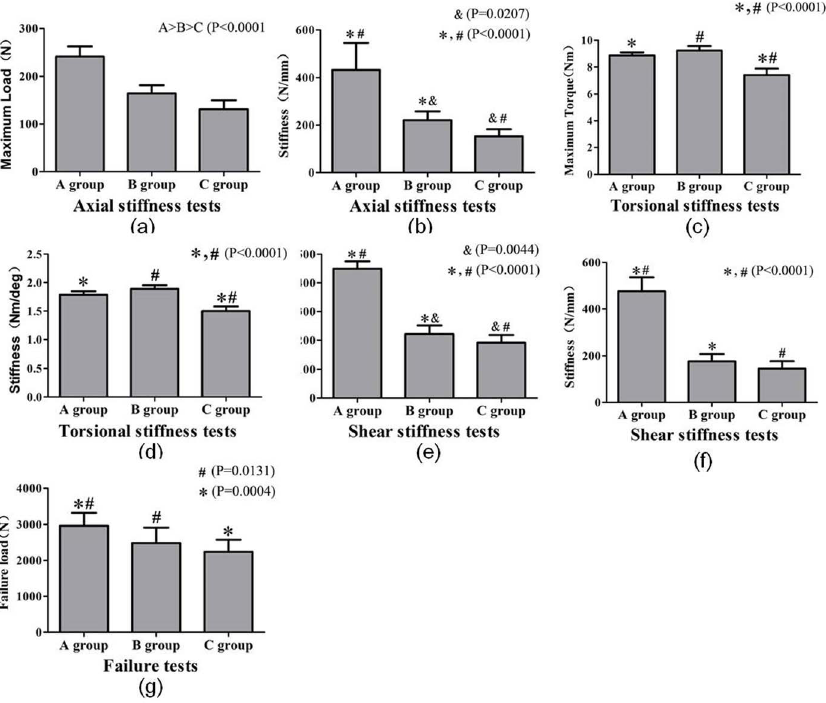
Figure 4. Comparison of stiffness tests among three groups under four load steps (a,b) axial stiffness test, (c, d) torsional stiffness test, (e, f) shear stiffness test, (g) failure test. Fig 4 a, Fig4 b Axial stiffness data for all subgroups. The maximum load and the axial stiffness showed statistical differences between the groups (Group A . Group B . Group C; P # 0.0207) Fig 4 c Torsional stiffness data for all subgroups. The maximum load of Group C was statistically different from both Group A and Group B, (Group A . Group C, Group B . Group C; *, # , P , 0.0001). The comparisons of Groups A and B for maximum load were not significantly different ( P =0.6086). Fig 4 d Torsional stiffness data for all subgroups. The torsional stiffness of Group C was statistically different from both Group A and Group B (Group A . Group C, Group B . Group C; *, # , P , 0.0001). The comparisons of Groups A and B for torsional stiffness were not significantly different ( P =0.2738). Fig 4 e Shear stiffness data for all subgroups. The maximum load showed statistical differences between the groups (Group A . Group B . Group C; P # 0.0044). Fig4 f Shear stiffness data for all subgroups. The shear stiffness of Group A was statistically different from both Group B and Group C (Group A . Group B, Group A . Group C; *, # , P , 0.0001). The comparisons of Groups B and C for shear stiffness were not significantly different ( P =0.0561). Fig 4 g The load-to-failure of Group A was statistically different from both Group B and Group C (Group A . Group B, Group A . Group C; *, # , P # 0.0131); however, no statistical differences were noted between Group B and Group C ( P